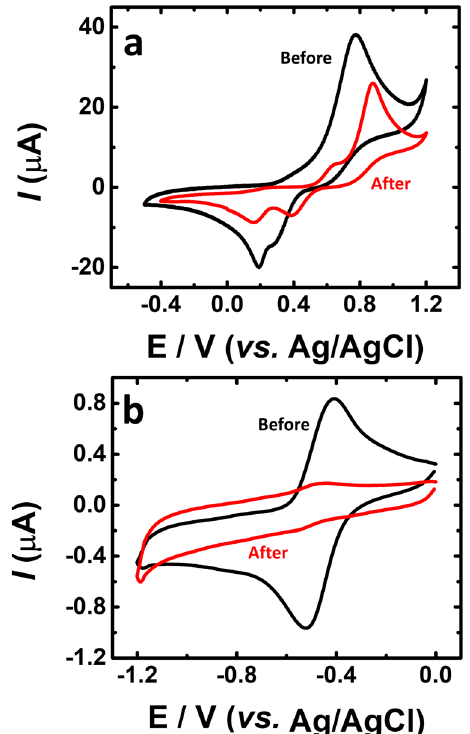
Fig. 8 Cyclic voltammetry curves before and after aqueous organometallic RFB cell test. Comparison between the catholyte (K 4 [Fe(CN) 6 ]·3H 2 O) ( a ) and anolyte (TRYP-SO 3 H) ( b ) solutions before (black curve) and after (red curve) aqueous organometallic active materials for RFB full cell test using 1.0 M KCl as supporting electrolyte. Solutions with saturated N 2 , υ = 50 mV s − 1 .